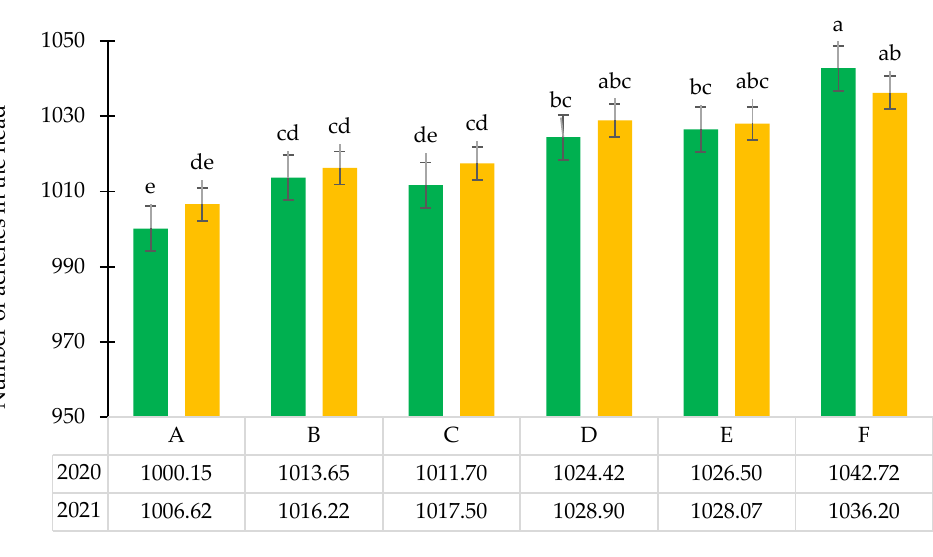
Figure 3. Number of achenes in the head. A–F—variants of fertilization. Different lowercase letters indicate significant differences ( p < 0.05) according to the analysis of variance (ANOVA).